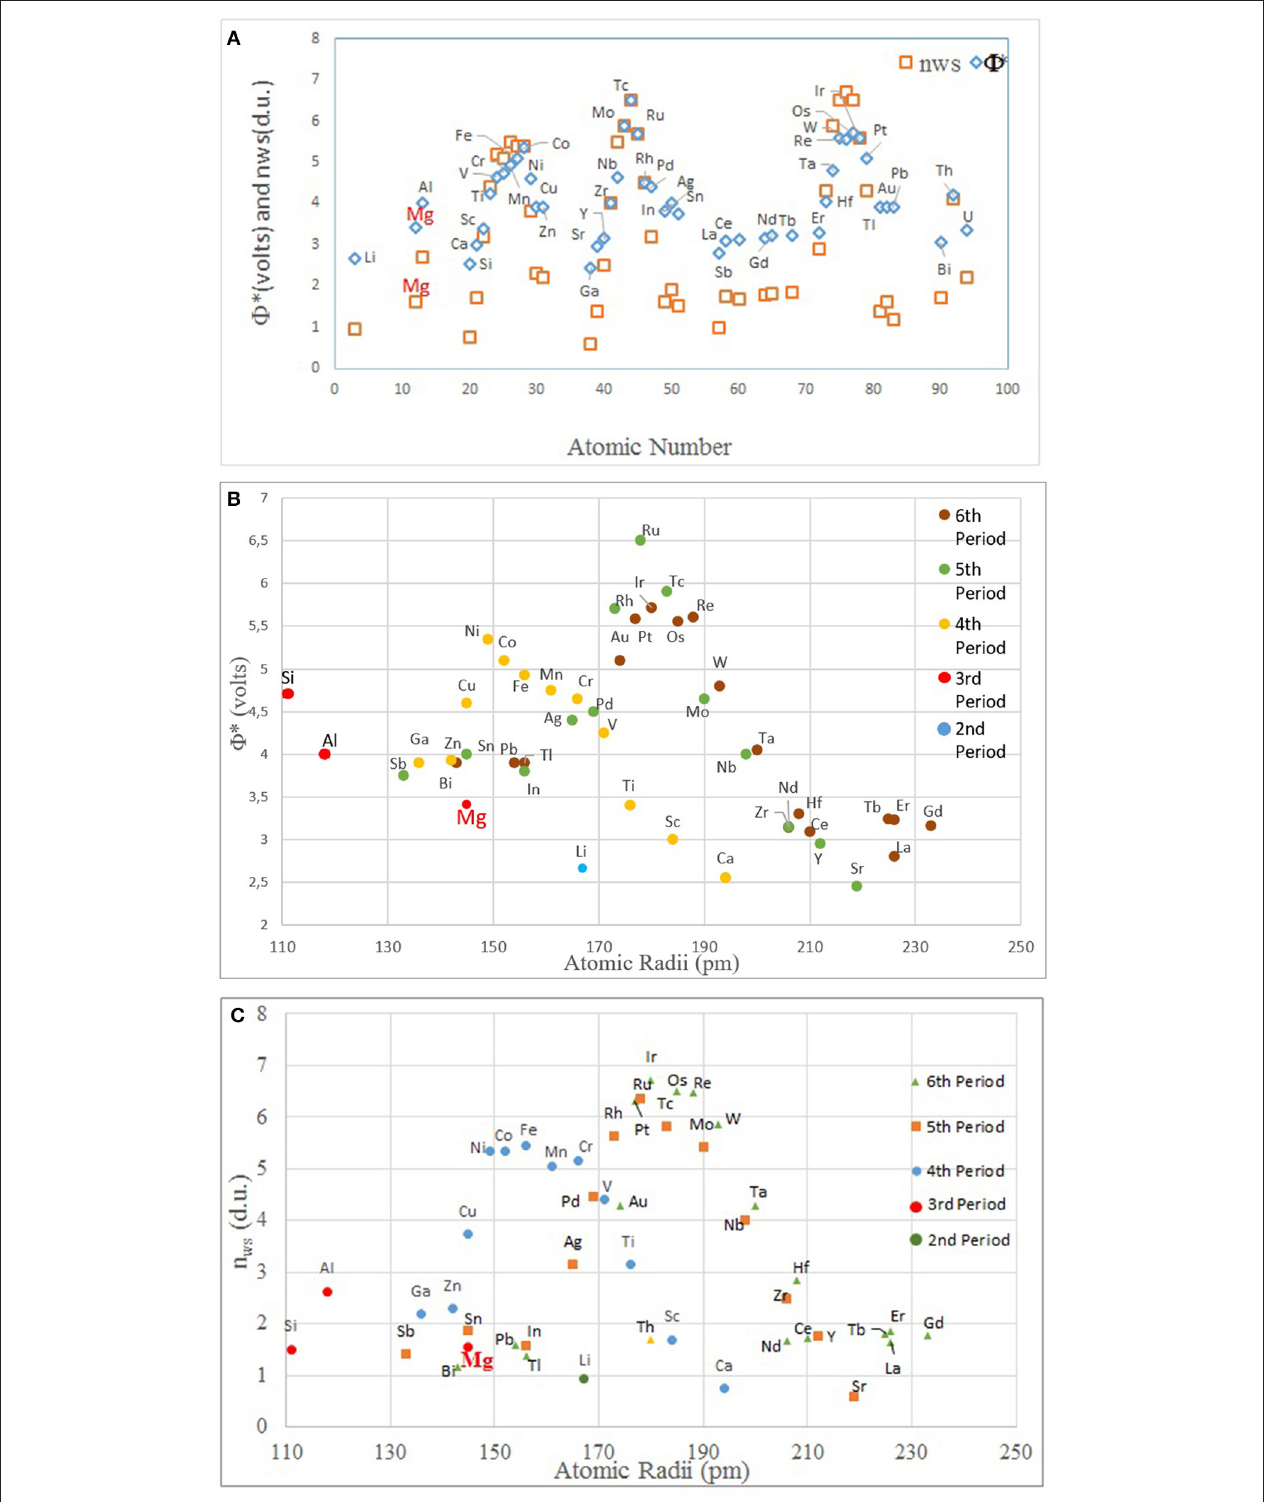
FIGURE 5 | The plots of (A) atomic number vs. n WS and Φ * (for clarity, the element names are only given for one data set, Φ *); (B) atomic size vs. Φ *; and (C) atomic size vs. n WS . Note that the modulations correspond to individual periods in the periodic table ( n WS and Φ * values are from Miedema, 1973a; Abaspour and Cáceres, 2015).